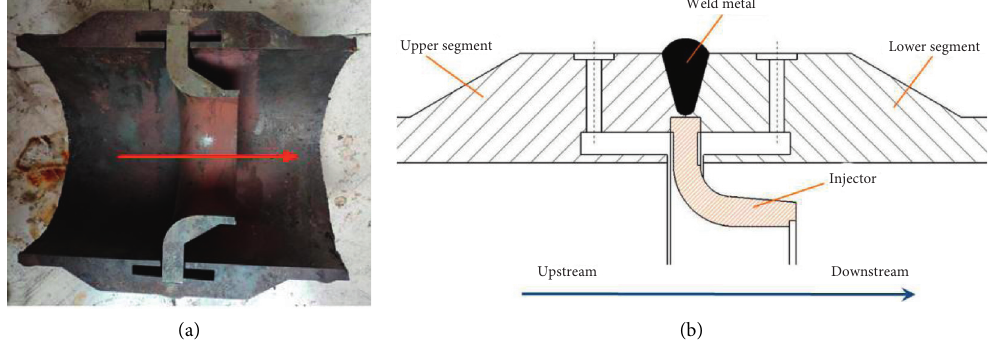
Figure 1: Overall structure. (a) Real products. (b) Basic structure.